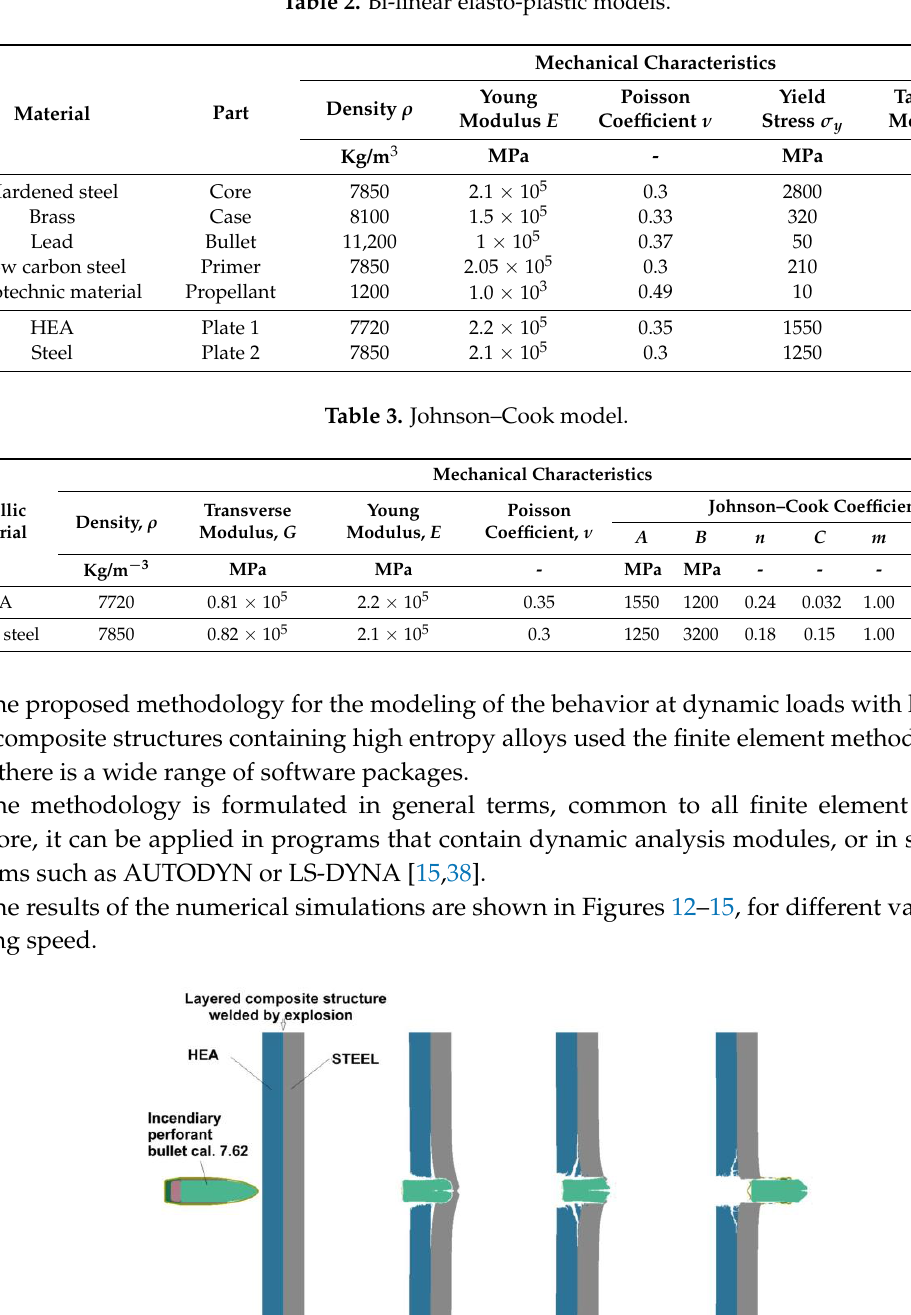
Figure 13. The behavior of the HEA-STEEL composite structure, welded to contour, at impact with an incendiary armor piercing bullet (7.62 mm caliber) with different initial speeds.